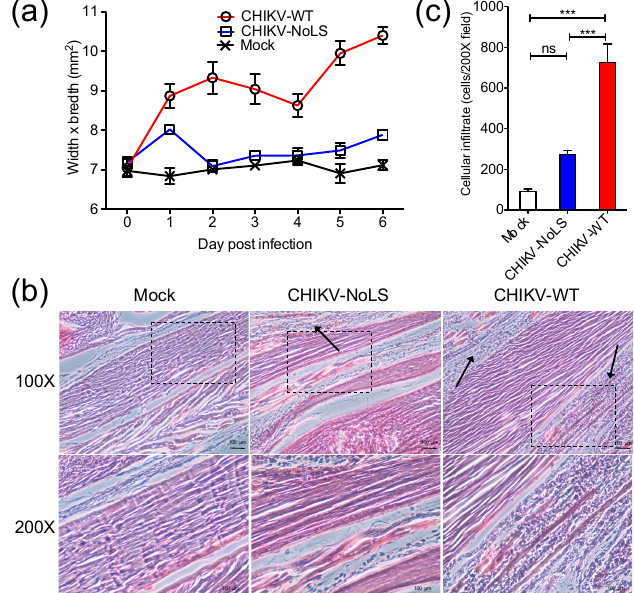
Figure 1. Histological analysis of the mouse footpad after inoculation with 10 4 plaque forming units (PFU) CHIKV-WT or CHIKV-NoLS. Twenty-eight-day-old C57BL/6 mice were inoculated in the ventral/lateral side of the right foot with 10 4 PFU CHIKV-WT or CHIKV-NoLS or mock-infected with (phosphate buffered saline) PBS alone. ( a ) CHIKV-induced footpad swelling was assessed daily by measuring the height and width of the perimetatarsal area of the hind foot. Each symbol represents the mean ± standard error from 5 mice; ( b ) Inoculated (ipsilateral) feet were dissected, processed for histological analysis and stained with H&E. Images at 100X and 200X magnification are representative of at least 6 fields of view. Black arrows indicate cellular infiltration. The black dashed box indicates